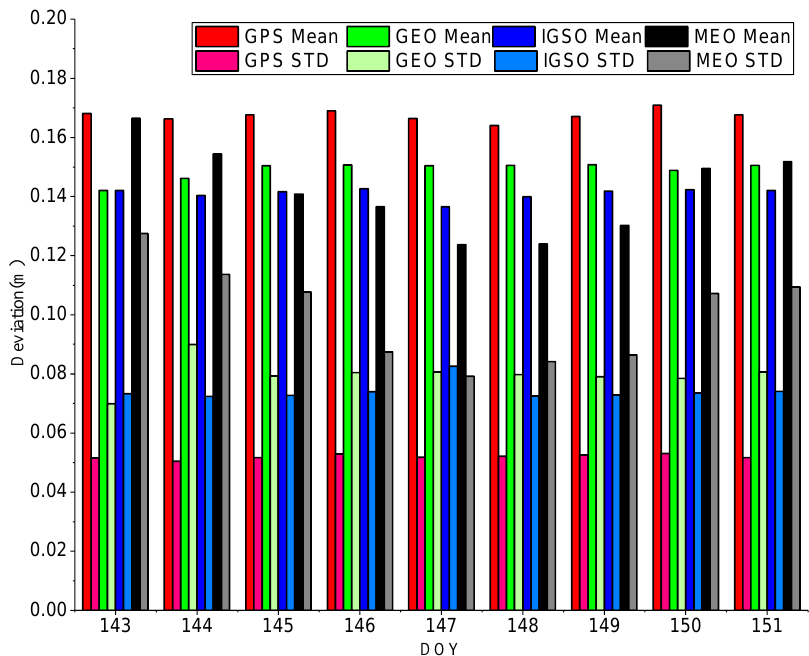
Figure 3. Trimble statistical results of the C/A and B1 code precision of different types of observations.